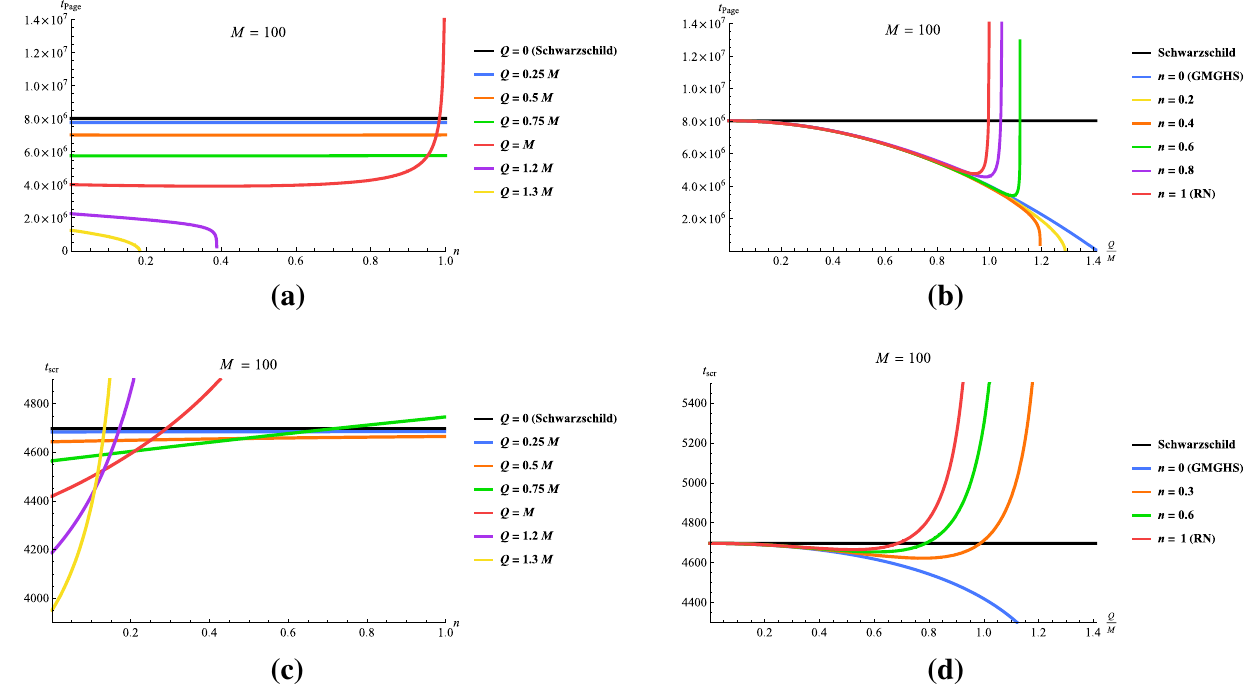
Fig. 4 The Page time and the scrambling time by GHS black holes as a function for the stringy coefficient n and charge Q (in the unit of 12 π/ c )